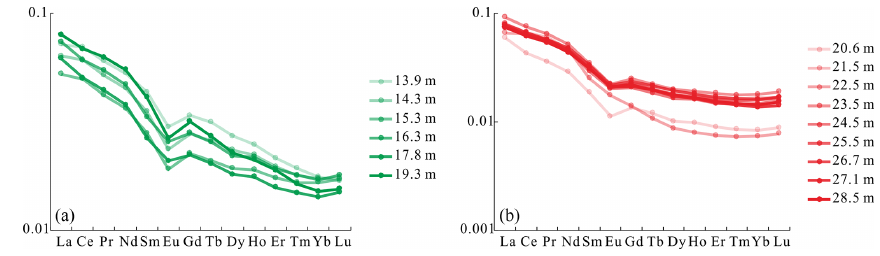
Figure 7. The REE pattern of basaltic andesite (a) and gabbroic diorite (b) at different